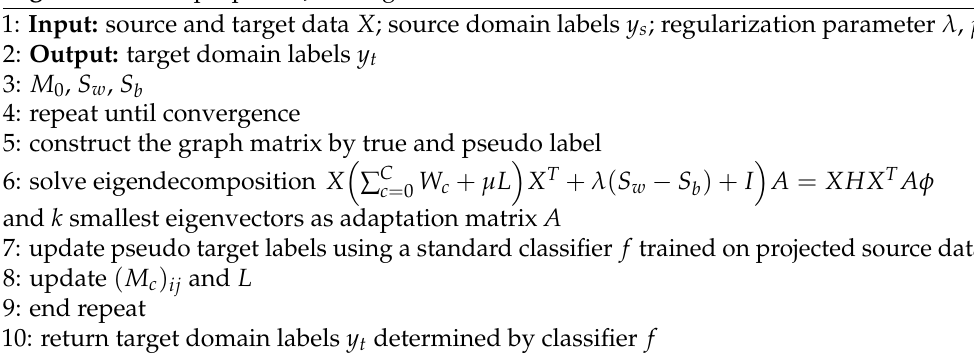
Algorithm 1 The proposed JSTL